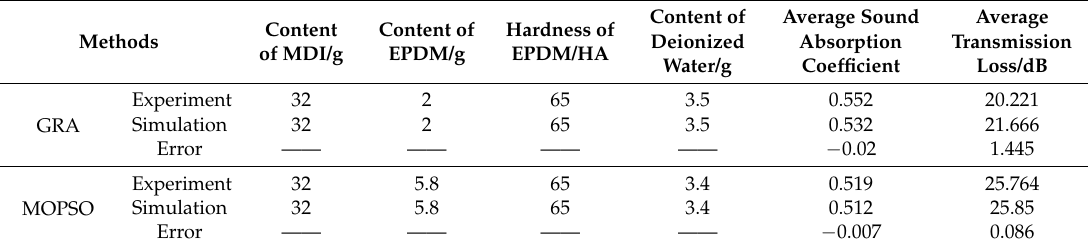
Table 8. Optimization results of simulation and actual